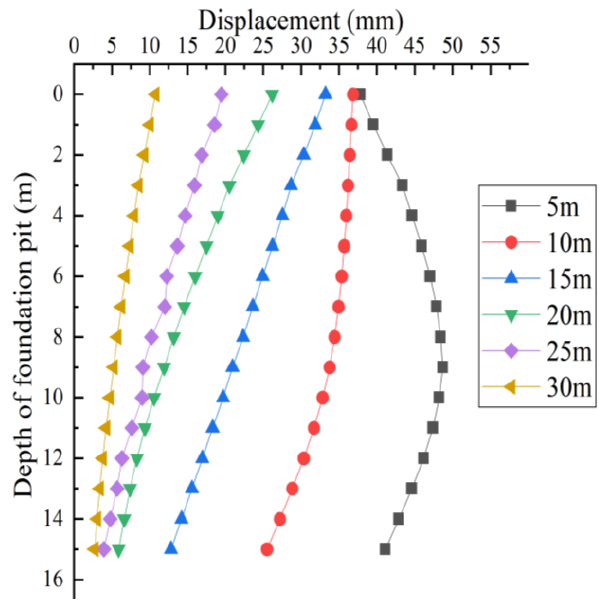
Figure 13. Pile displacement behavior.